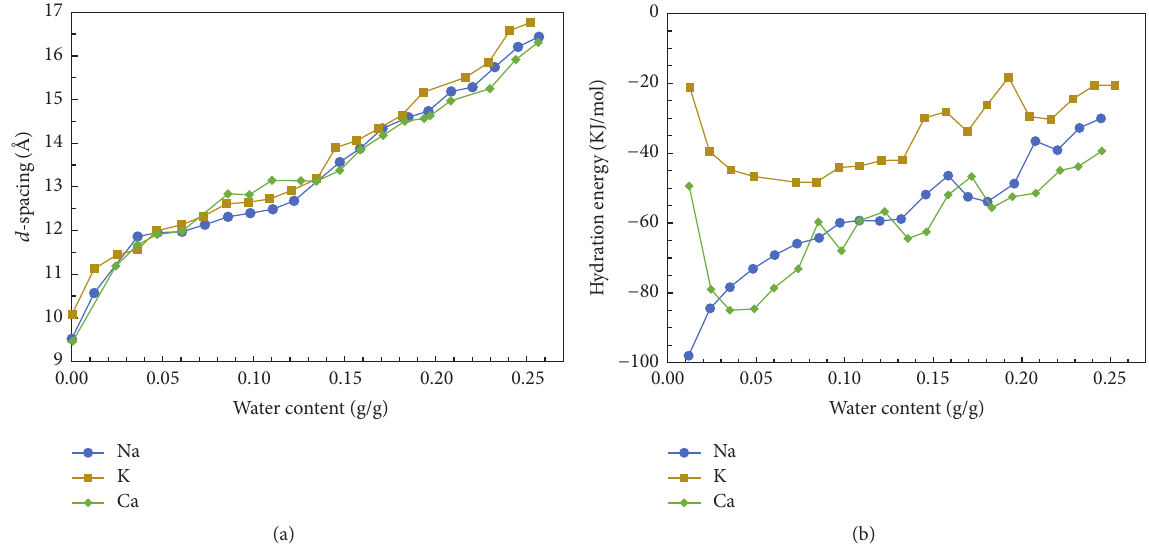
Figure4:Montmorilloniteswelling(basal 𝑑 -spacing)(a)andhydrationenergy(b)curvesasafunctionofwatercontentfromMDsimulations at 1 atm and 300